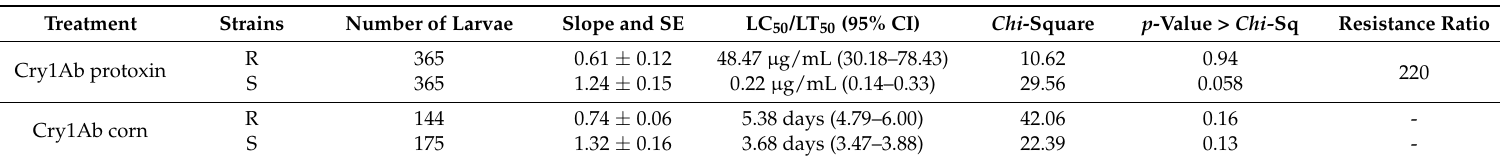
Table 1. LC 50 ( µ g/mL) and LT 50 (days) data from probit analysis for R- and S-strains of O. nubilalis larvae fed Cry1Ab protoxin and transgenic corn leaves expressing Cry1Ab toxin (Cry1Ab corn), respectively.